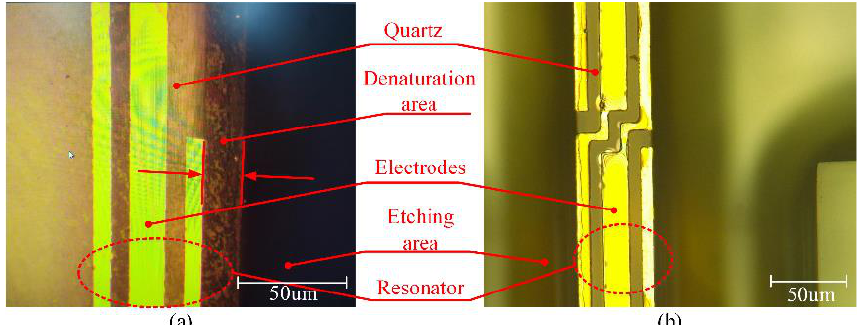
Figure 19. ( a ) The picture of the etched quartz structure with laser ablation under a light microscope; ( b ) the picture of the etched quartz structure with plasma etching under a light microscope.